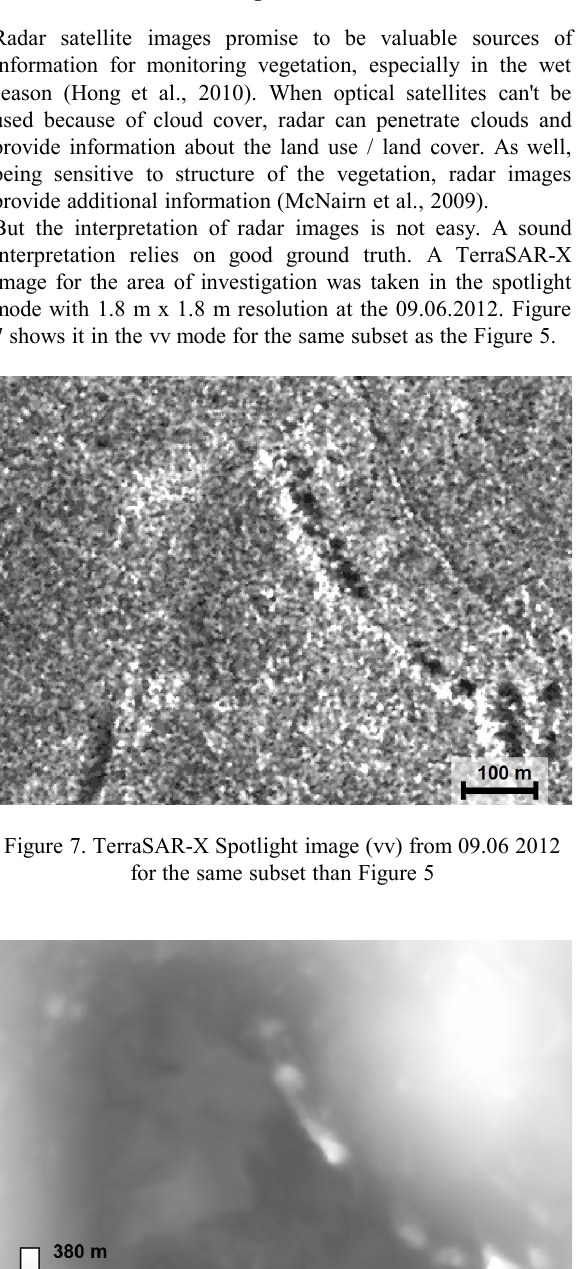
Figure 6. Change detection between May and August 2012 principle component analysis of the layer stack of both images. Areas with less vegetation turn out turquoise (red-PC2, green- PC5, blue-PC5).